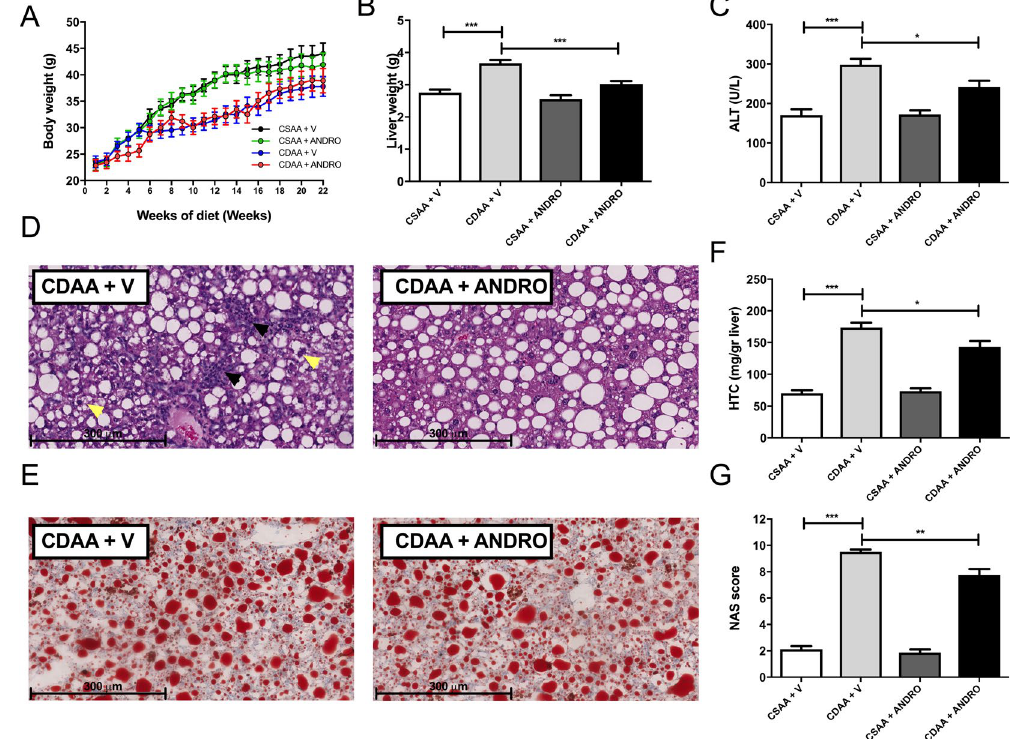
Figure 1. Andrographolide-treated mice are protected from CDAA-induced hepatomegaly and liver injury. Mice weaned after 21 days were placed on normal chow diet for 4 weeks and thereafter placed either on choline-deficient amino acid-defined (CDAA) or choline-supplemented L-amino acid defined (CSAA) diets for an additional 22 weeks. During this period mice were injected with AP three times per week (1 mg/kg, intraperitoneally). ( A ) Body weight gain, ( B ) Liver weight, ( C ) alanine aminotransferase (ALT) serum levels, ( D ) Histological evaluation of liver tissue (hematoxylin/eosin staining), inflammatory foci and hepatocyte ballooning are indicated by black and yellow arrows respectively. ( E ) Hepatic triglyceride content (HTC). ( F ) Oil-red-O staining of liver samples. ( G ) Non-alcoholic activity score (NAS) as assessed by a pathologist in a blindly fashion. Data are shown as means ± SEM. Statistical significance was evaluated using ANOVA with a post-hoc Bonferroni multiple-comparison test ( * p ≤ 0.05, ** p ≤ 0.01 and *** p ≤